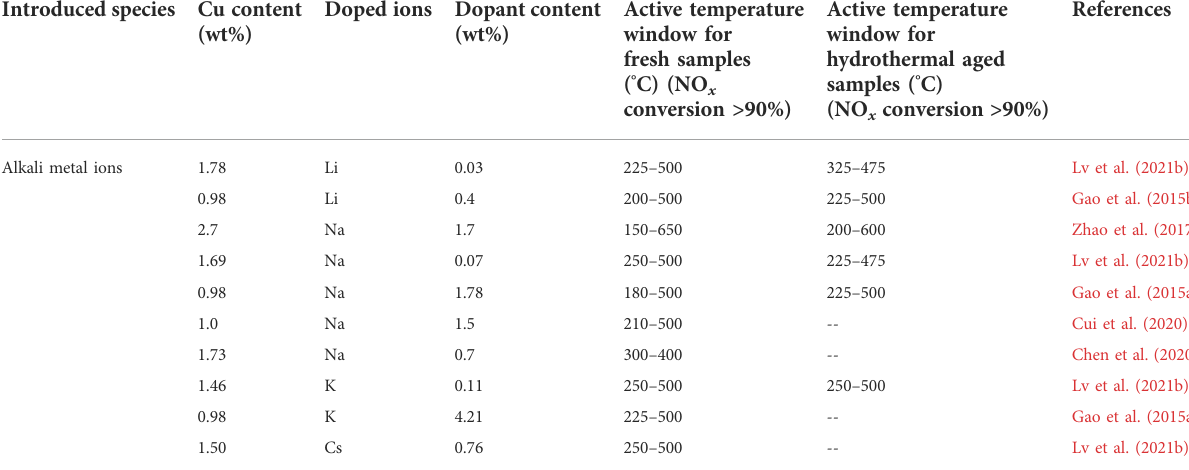
TABLE 1 Summary of the Cu-SSZ-13 catalysts doped with alkali metal ions. Introduced species Cu content (wt%)